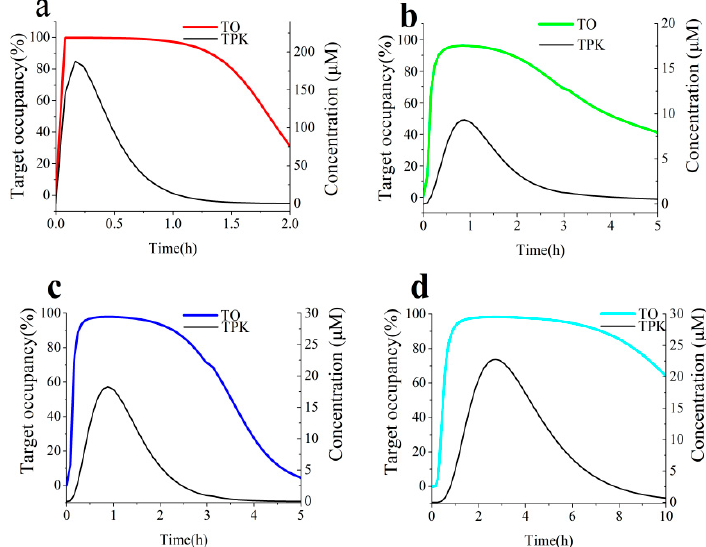
Figure 9. Simulations of the time course of AGH engagement by EGCG in the UWLs of the four di ff erent intestinal segments in rat with BK-TPK model ( a ) duodenum, ( b ) jejunum, ( c ) ileum, ( d ) colon. Black solid lines represent TPK concentration-time profiles; red, green, blue and cyan solid lines represent TO time course profiles.